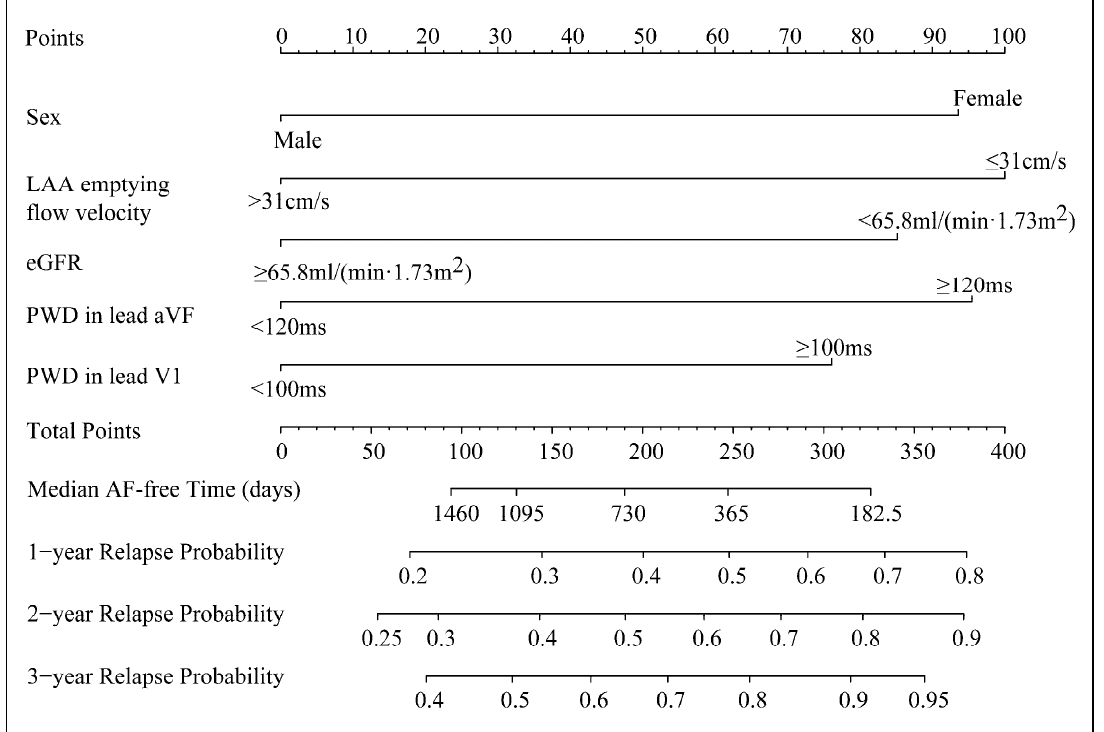
Figure 4. The five-factor nomogram.